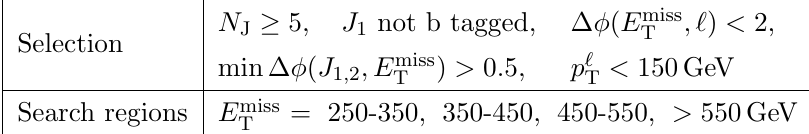
Table 3 . Summary of the compressed selection and the requirements for the four corresponding signal regions. The symbol (cid:1) (cid:30) ( E miss and J 1 denotes the highest p T